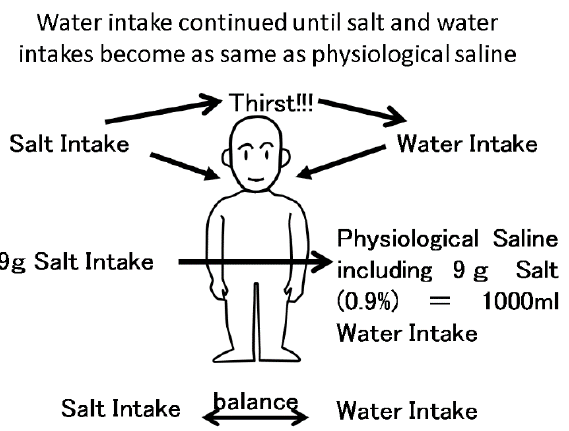
Figure 2. The balance between salt intake and water intake. Salt intake is balanced with water intake via the thirst center. After 9 g of salt intake, a person wants to drink 1000 mL water, resulting in 0.9% physiological saline in extracellular fluid. If the person does not drink enough water, the concentration of sodium will increase, resulting in strong thirst.